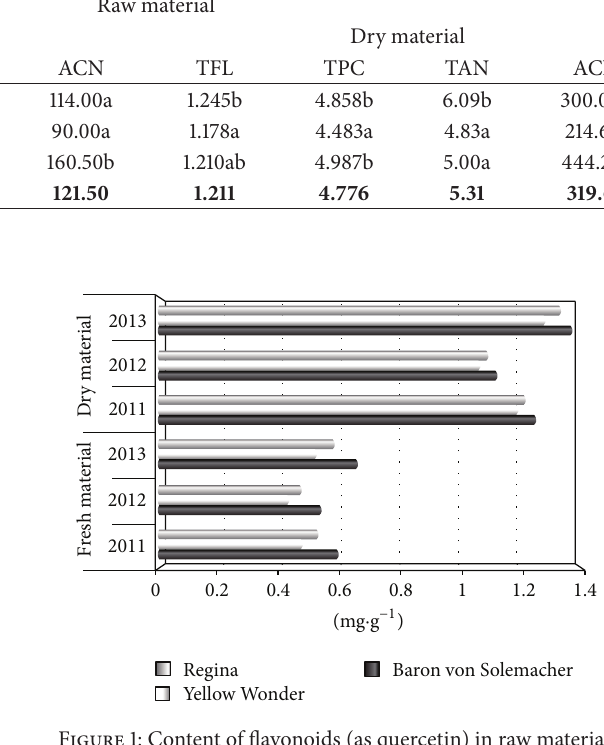
Figure 1: Content of flavonoids (as quercetin) in raw material.